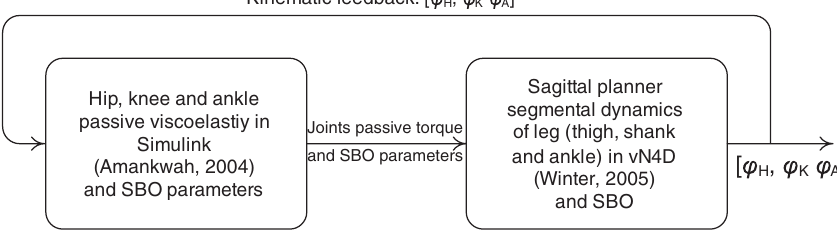
Fig. 2. Schematic of the leg model. ϕ H , ϕ K and ϕ A are hip, knee and ankle angles